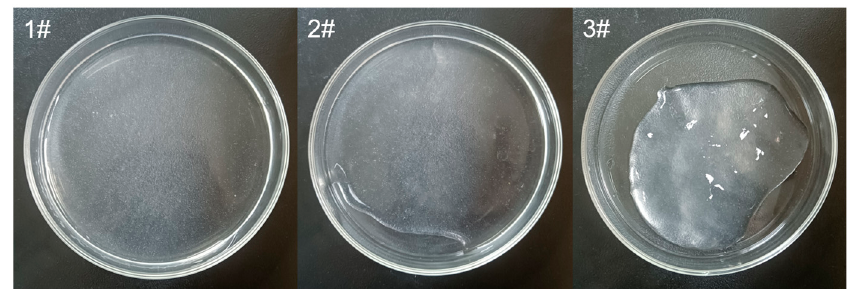
Figure 14. Thickened liquids for patients with KGM-mediated dysphagia.